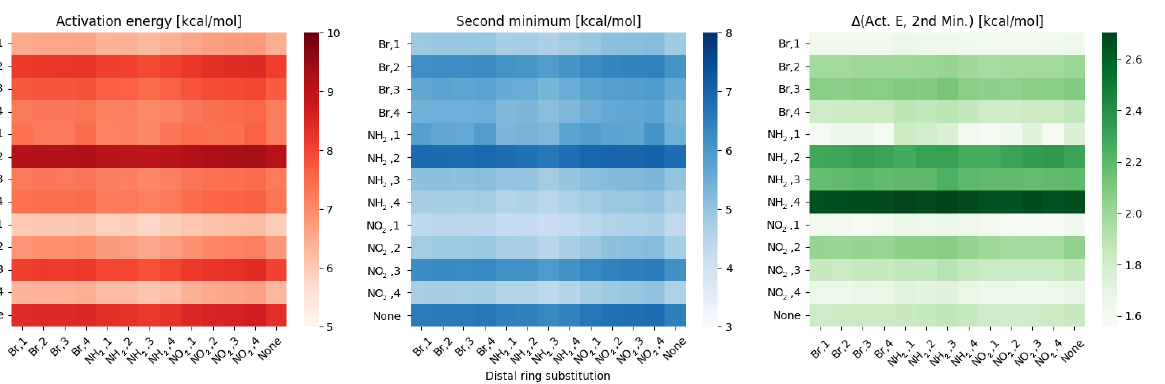
Figure 1. Heatmaps of the activation energy ( left ), second minimum ( middle ) and the difference between them ( right ) for different substitution patterns in the meta compounds group.